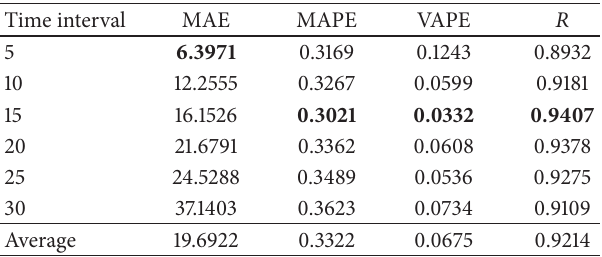
Table 3: Comparison of performance among WNNMs with differ- ent time